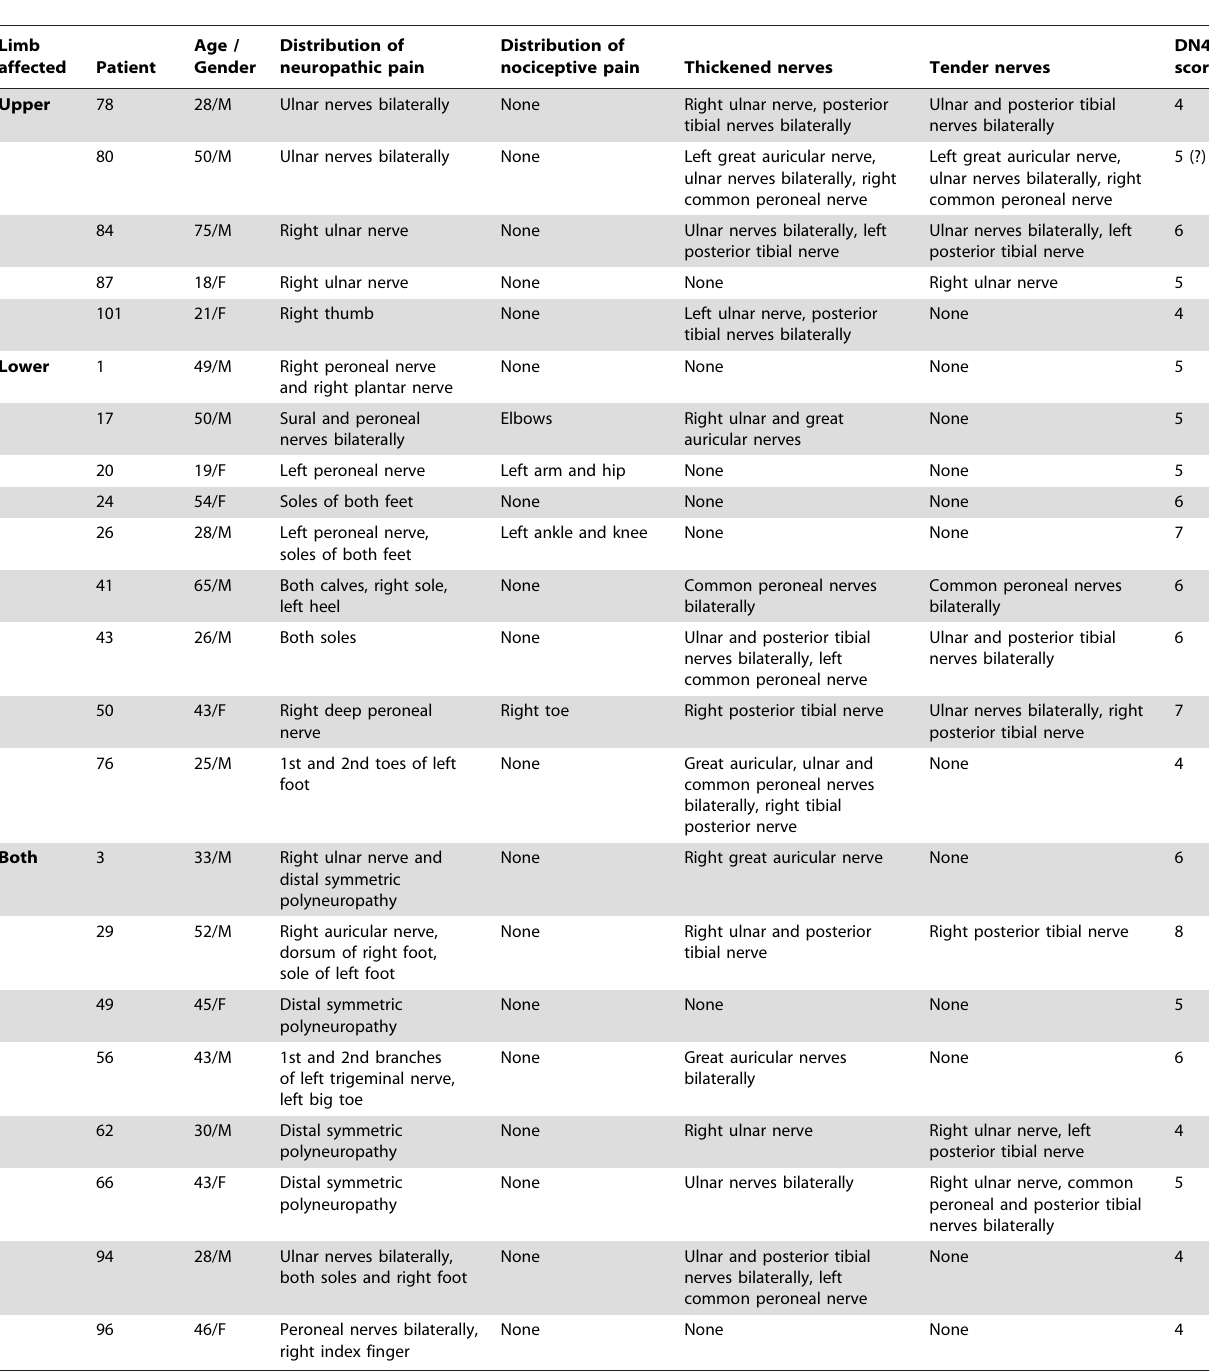
Table 2. Features of neuropathic pain in